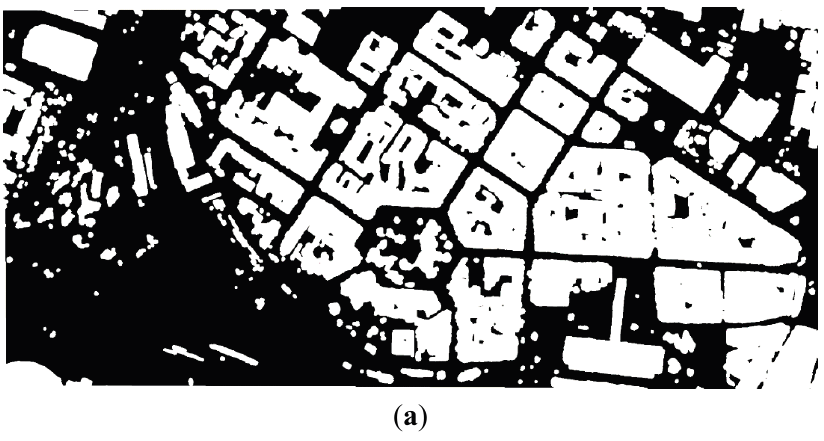
Figure 6. Binarization and thinning results for the OESM data of the overlapping areas in Figure 5. ( a ) Binary image of the overlapping area in Figure 5 in which the white region is the higher area and the black region is the lower area; ( b ) thinning result of the black region of